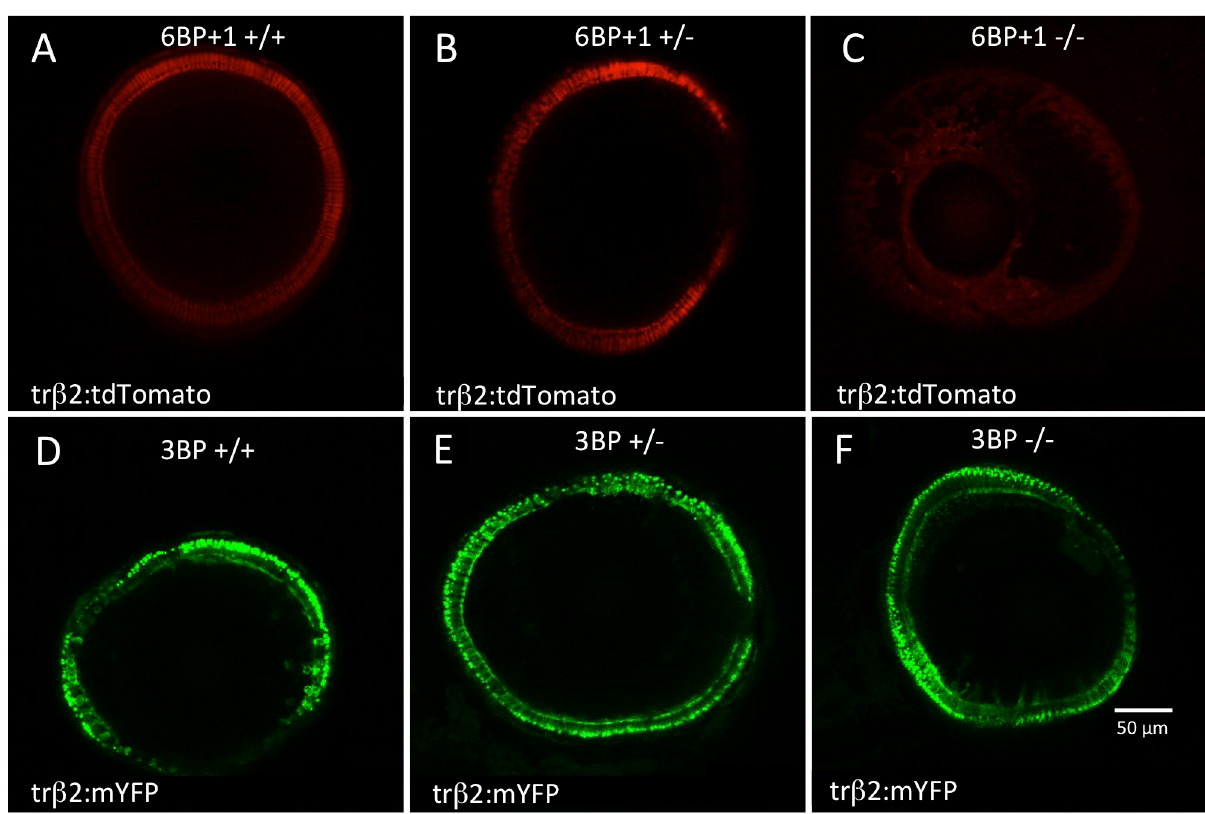
Fig 2. Live confocal imaging of larval eyes at 4- and 5-days post fertilization (dpf). (A) A confocal cross section of a wild type ( 6BP+/+ ) (N = 4) larval eye shows a ring of cone layer tdTomato fluorescence under control of a tr β 2 promoter in the red cones at the outer edge of the retina. (B) A 6BP+1 +/- heterozygote maintains (N = 7) tr β 2 fluorescence, but the 6BP+1-/- mutant (N = 14) (C) has no tr β 2 fluorescence. The 3BP wild type (N = 12) (D), heterozygote (N = 23) (E), and mutant (N = 5) (F) all exhibit tr β 2 fluorescence shown through mYFP expressed by a tr β 2 promoter. Eyes are imaged from the larval anterior side showing a cross-section ring of cones. Fluorescence in a ring or semi-ring formation indicates the presence of tr β 2 activity. Missing sections of the rings are due to image planes cutting through the cornea.